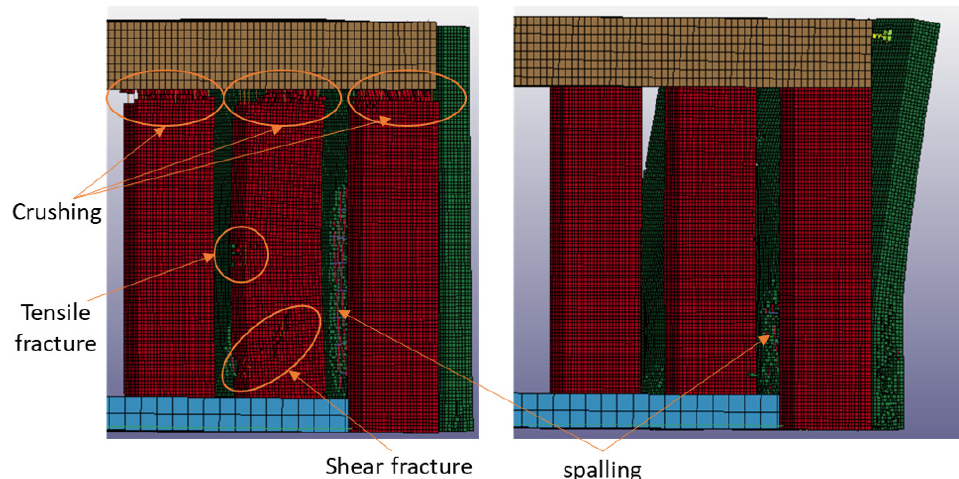
Figure 20. Post-blast effective plastic strain scenario (iii): 150 kg TNT at 2.5 m standoff.